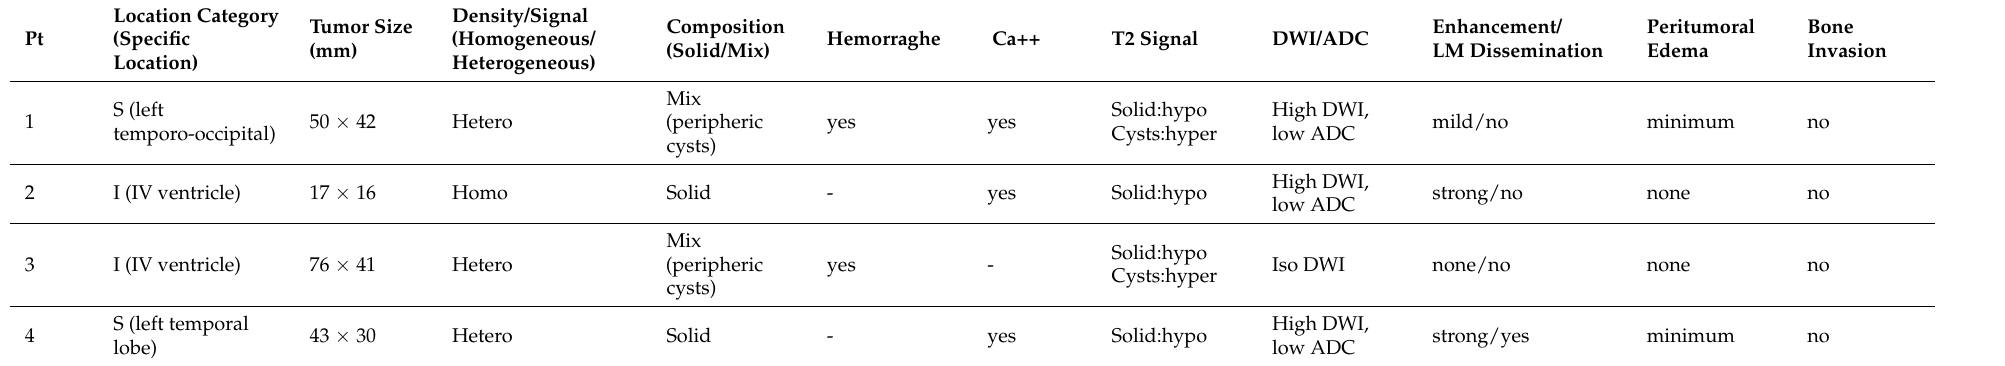
Table 2. Preoperative imaging findings in 11 patients with atypical teratoid rhabdoid